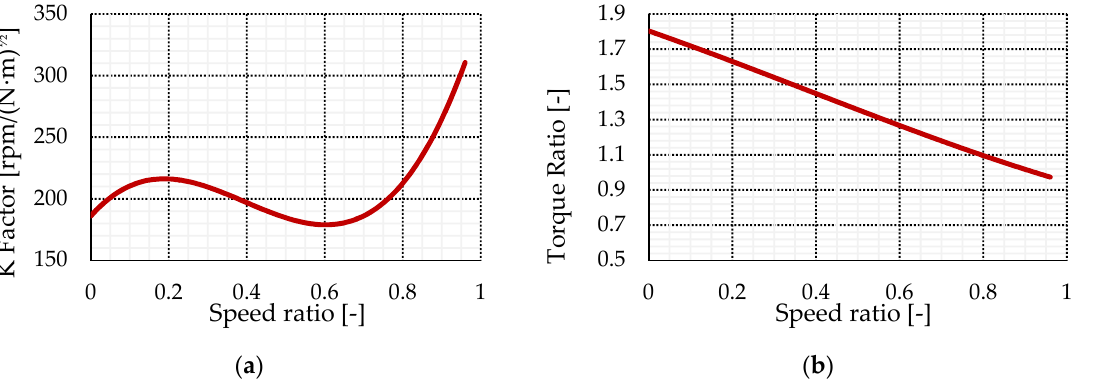
Figure 4. Waveform of values [74]: ( a ) K-factor as a function of speed ratio ν ; ( b ) conversion ratio μ as a function of speed ratio ν .